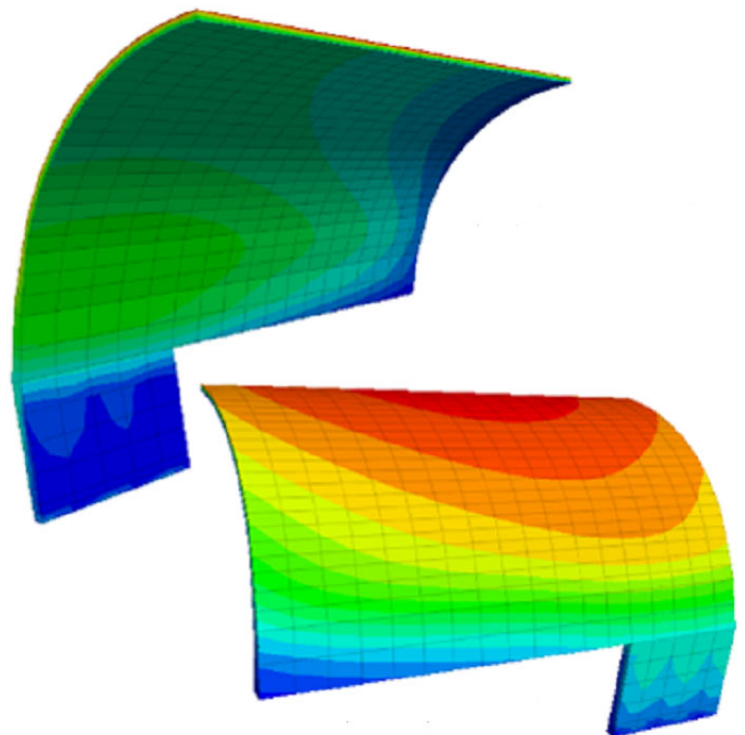
Figure 32. Total displacements (in meters) in the concrete elements, from blue 5.77 × 10 − 4 , to red 3.61 × 10 − 2 . Minimum parameters.